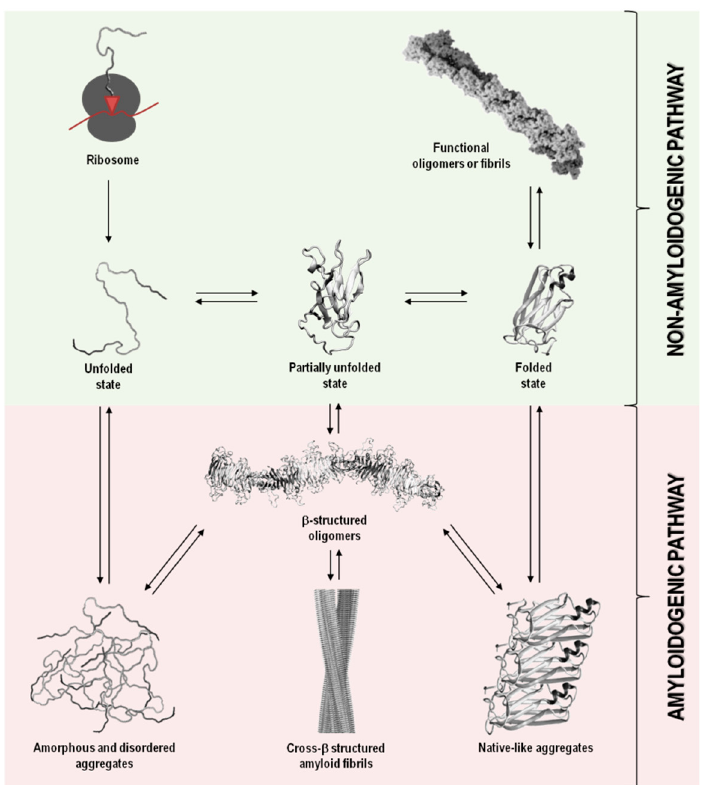
Figure 1. Schematic representation of the variety of conformational states that can be adopted by a polypeptide chain upon biosynthesis in the ribosome. The non-amyloidogenic pathway includes the formation of native sates and functional amyloids. The amyloidogenic pathway associated with pathological states can result from the formation of amorphous aggregates, amyloid aggregates and fibrils, and native-like aggregates. Adapted from reference [1].